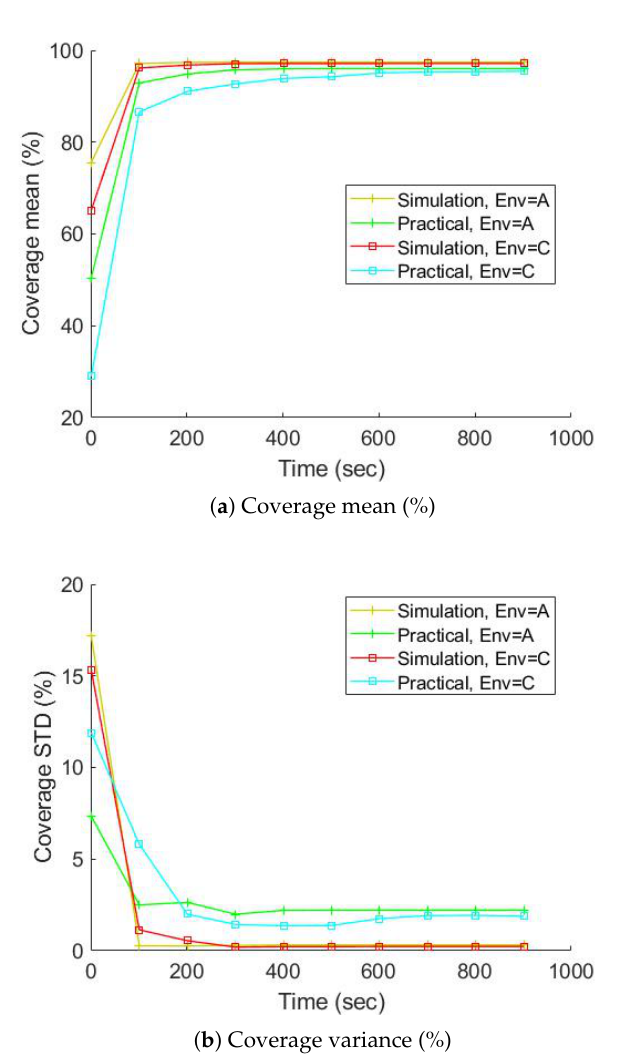
Figure 17. Comparison of the coverage of the obstacle map from the simulation, and from using the real robot, average over ten trials.